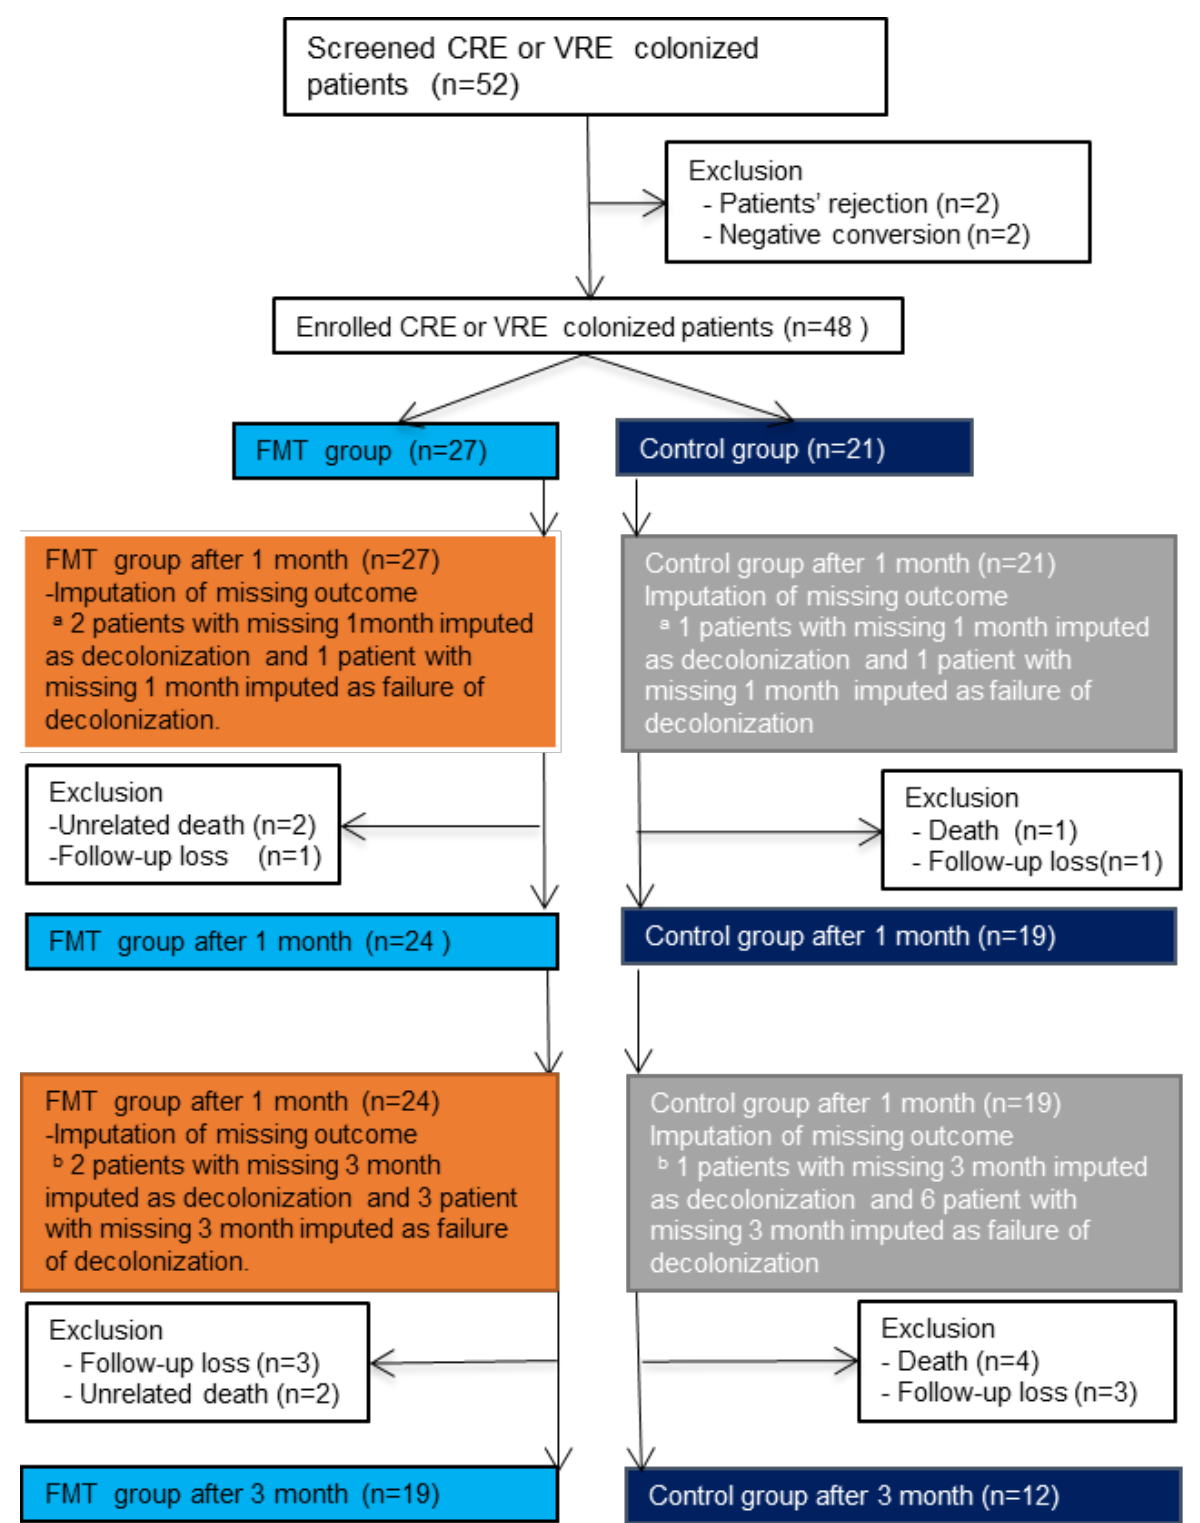
Figure 1. Flow chart of patient enrolment. a: imputation of missing outcome from enrollment to 1 month. b: imputation of missing outcome from 1 month to 3 month